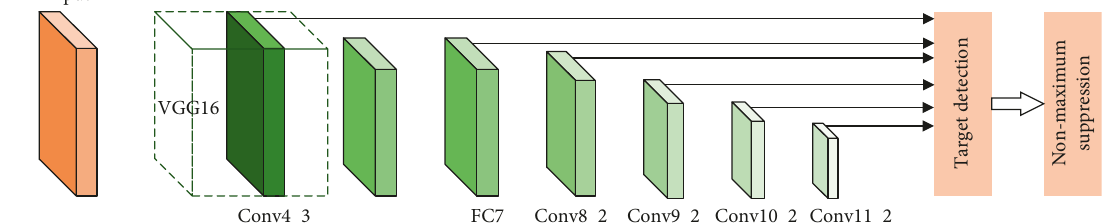
Figure 1: Structure of SSD